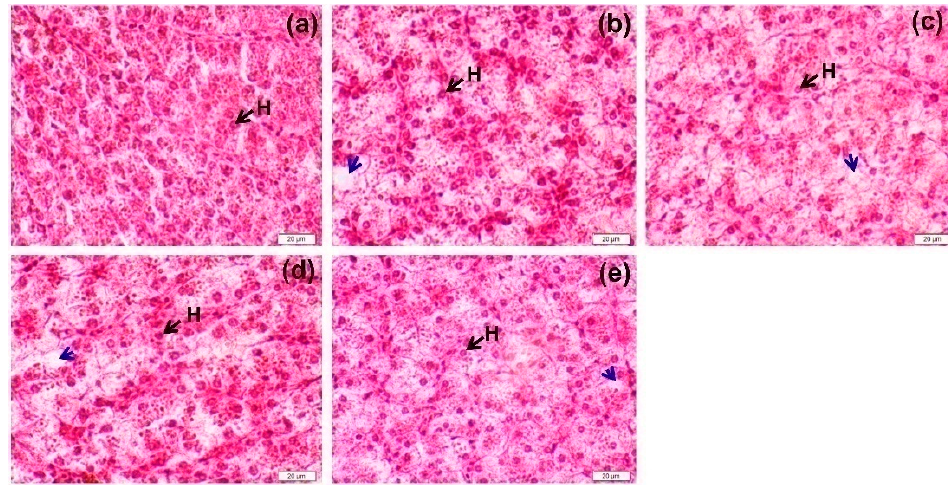
Figure 1. The liver histoarchitecture (longitudinal section) for sex-reversed Nile tilapia fed 0SW ( a ), 10SW ( b ), 20SW ( c ), 30SW ( d ) and 50SW ( e ) for 8 months. Tissues were stained with hematoxylin and eosin (H&E) and the images were photographed at 400× magnification. H = hepatocyte, blue arrows = cells accumulating lipids.